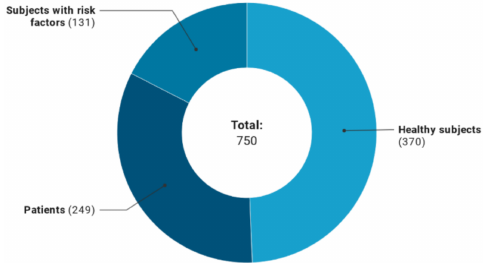
Figure 6. Health status of subjects included in the registered clinical trials.